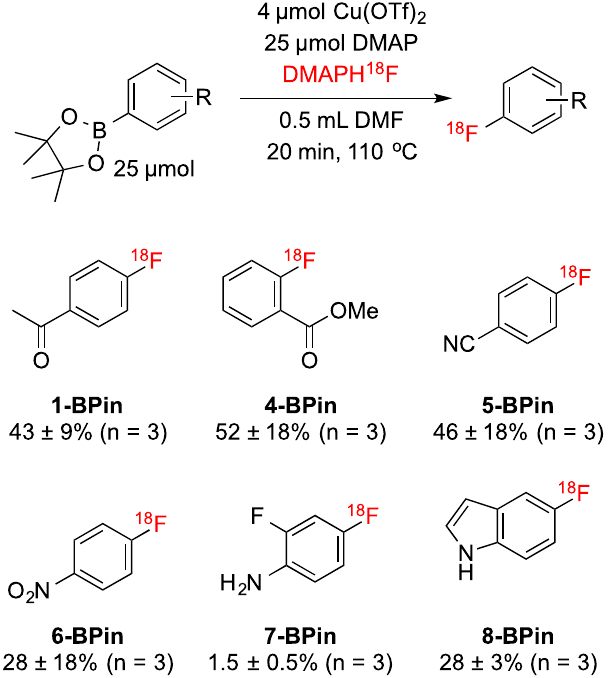
Figure 4. Substrate Scope RCCs. Conditions: 25 µ mol of BPin, 4 µ mol of Cu(OTf) 2 , and 25 µ mol of DMAP in 0.5 mL of DMF, DMAPH 18 F, 110 °C, 20